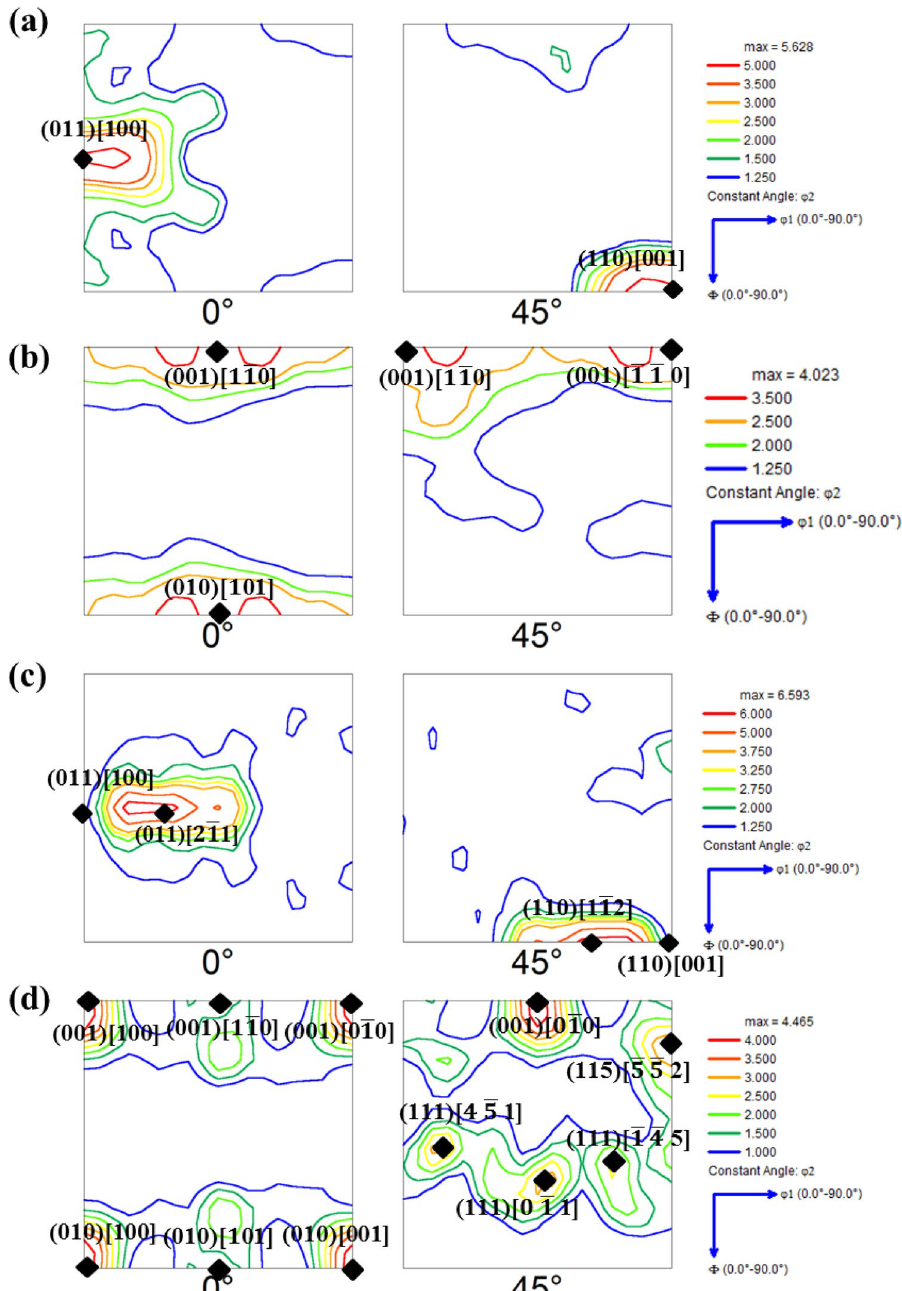
Figure 7. φ 2 = 0° and 45° sections of hot bands from ( a ) left surface of Cast 1; ( b ) center of Cast 1; ( c ) right surface of Cast 2; ( d ) center of Cast